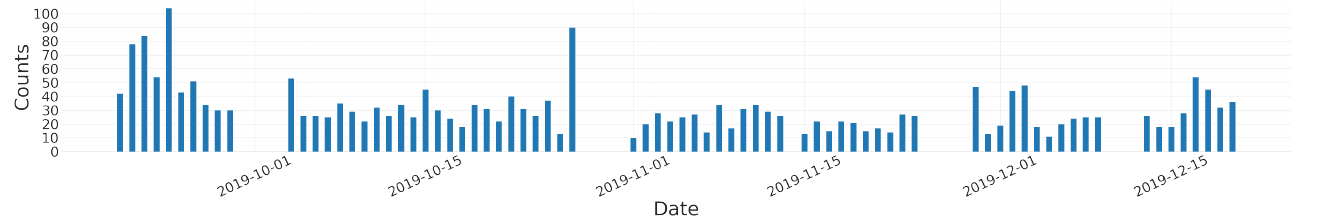
Figure A1. Interlock occurrences per day from 18-9-2019 to 25-12-2019. Regular maintenance periods can be observed.